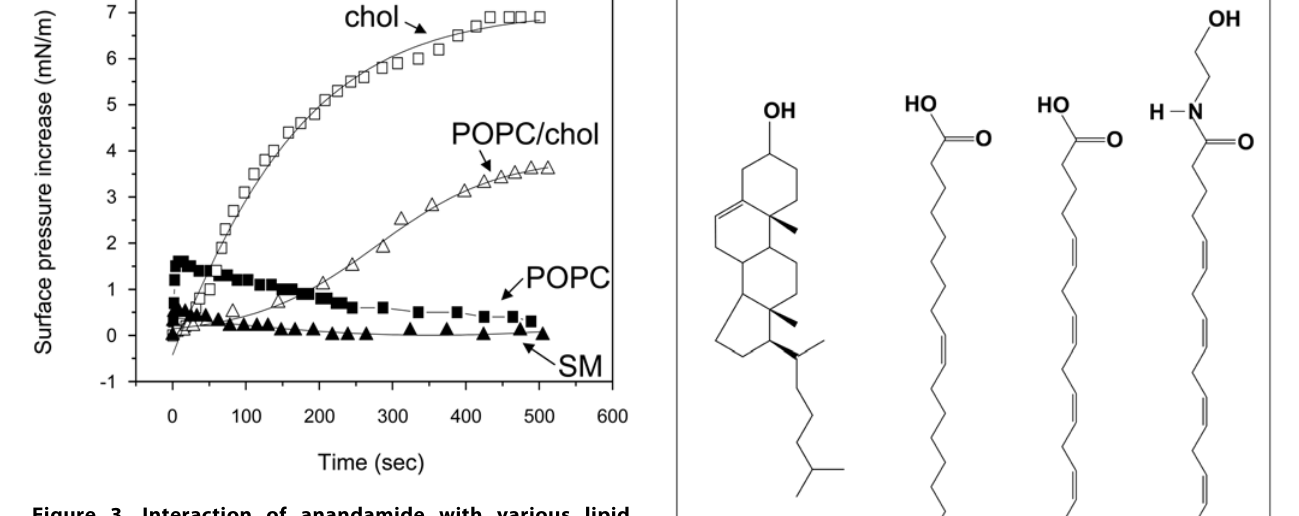
Figure 3. Interaction of anandamide with various lipid monolayers. The indicated lipid was spread at the air-water interface to form a compressible monolayer at an initial pressure comprised 20– 25 mN.m 2 1 . After stabilization of the monolayer, anandamide was added in the aqueous subphase (final concentration 50 nM). Under these specific conditions, anandamide does not modify the surface tension of water (not shown), so that it will have no effect on the surface pressure by itself. Thus, any change in the surface pressure indicates an interaction of anandamide with the lipid monolayer. The data are expressed as the variation of the surface pressure as a function of time following the addition of anandamide. The following lipids were spread at the air-water interface: pure POPC (full squares), pure cholesterol (open squares), mixed POPC-cholesterol film (1:2, mol:mol, open triangles), pure SM (full triangles).